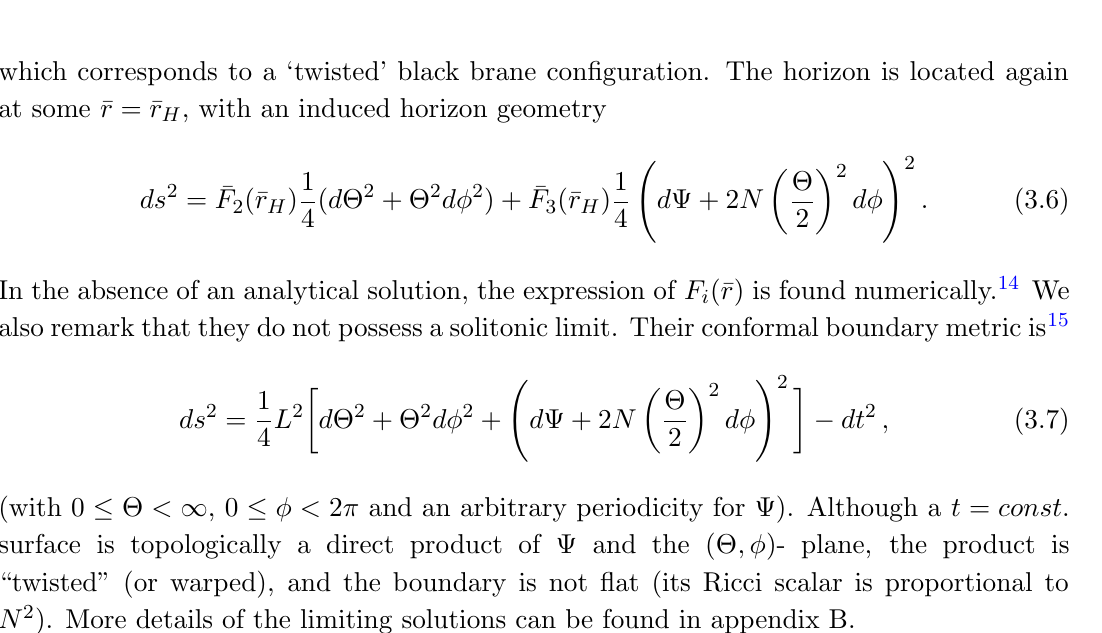
Figure 3. (a) Metric and gauge functions are shown for a typical squashed magnetized black hole. The input parameters here are L = 1, r H = 0 : 492, Q = (cid:0) 3 : 19, J = (cid:0) 1 : 33, c m = (cid:0) 0 : 5 and v 2 = 0 : 133. (b) Same functions for a squashed magnetized soliton with parameters L = 1, c m = 0 : 8 and v 2 = 0 :